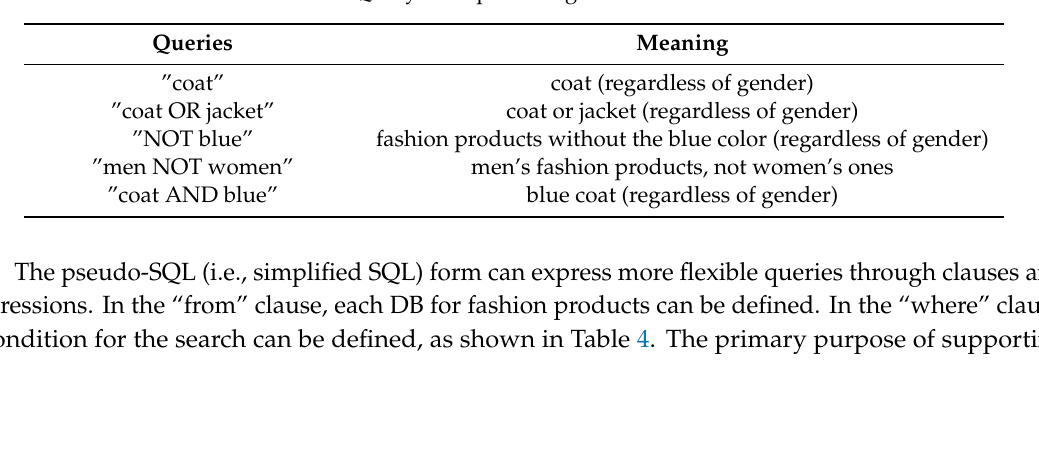
Table 3. Query examples using the Boolean